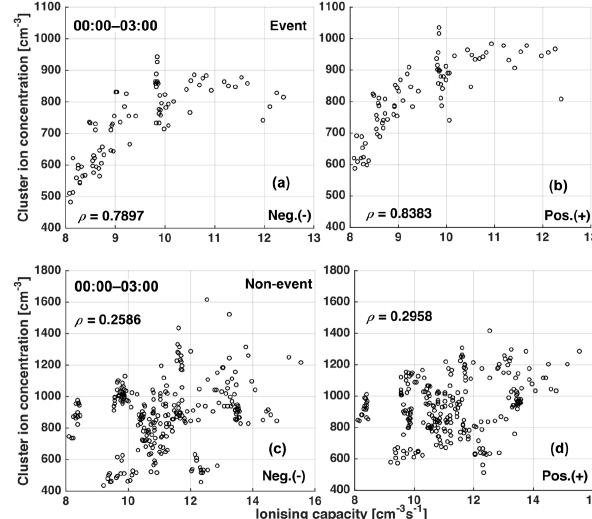
of the ionising capacity (radon ionising capacity + gamma ionising capacity) for selected data in the years 2003–2006, with Spearman’s rank correlation coefficient ( ρ ). The data were constrained on (a, b) event days and (c, d) non-event days in September–December be- tween 00:00 and 03:00 with the wind direction between 280 and 30 ◦ and the condensation sink (CS) below 0.002s − 1 . No dependence of the cluster ion concentration on the CS or hour-of-day was identi- fied. Also the snow season was screened out. The negative polarity is shown in (a, c) and the positive in (b, d)